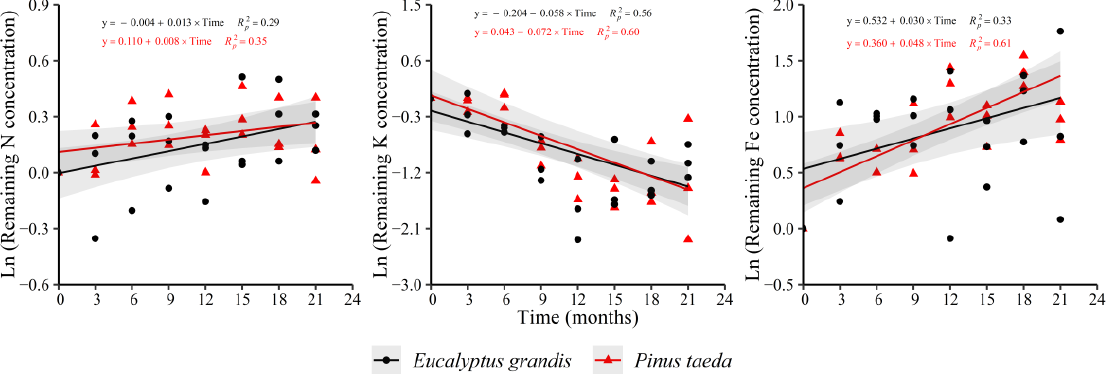
Figure 2. Remaining nutrient concentration of E. grandis (black symbols) and P. taeda (red symbols) litter for the different sampling moments (C1 layer). The gray bands around the models represent the 95% confidence interval.